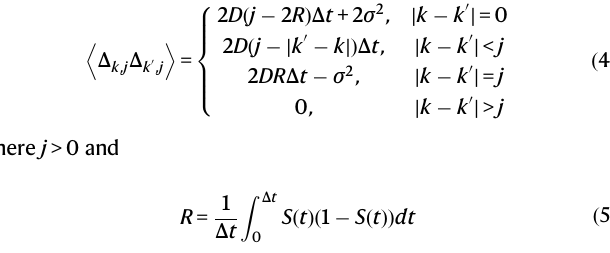
estimateddiffusionsoverthetrajectoryin( a ). c DistributionofallECVEvaluesfrom 100trajectories.The3stateHMMmodelpredictionoftheemissiondistributionsis plotted on top of the histogram, and the inverse-gamma mean and SD of each emissiondistributionisreportedwithstandarderrorfromabootstrapanalysisover trajectories in the legend. Inset, 3D representation of the cell volume with ground truthtrajectoryinblackandtheestimatedpathinyellow.Sourcedataareprovided as a Source Data fi